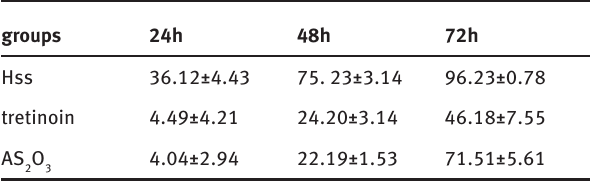
Table 2: The inhibition rate,of Hss, tretinoin and AS tion of HL-60 cell